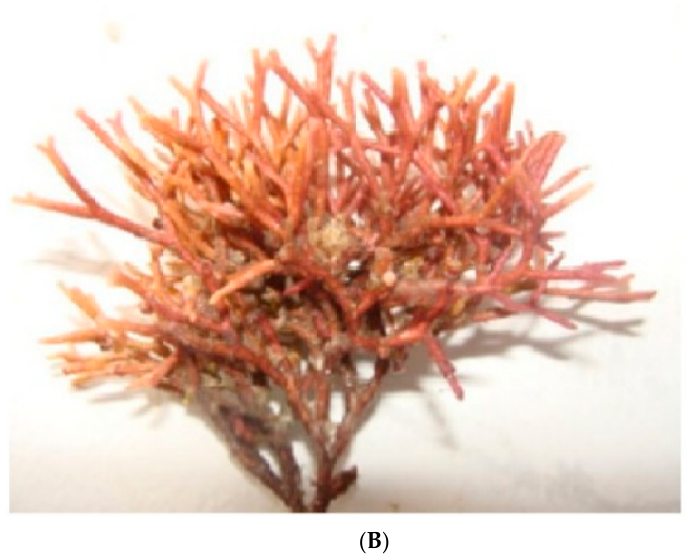
Figure 1. Collected seaweeds from Red Sea ( A ), H. cuneiformis , and ( B ), A. fragilis . 2.2. Physico-Chemical and Biochemical Analysis of Seaweeds and Resulted Extracts The color and pH of both seaweed extracts were measured in the laboratory before preparation. Calcium, potassium, magnesium, and sodium were also estimated using a flame photometer (CORN NG 400, Mateo, CA, USA). Total carbohydrates in liquid ex- tracts of both seaweeds were estimated by the anthrone sulphuric acid method [27]. Soluble proteins were determined according to [28] protocol. Total lipid content was an- alyzed following [29]. Physicochemical analysis of each seaweed extract is as shown be-